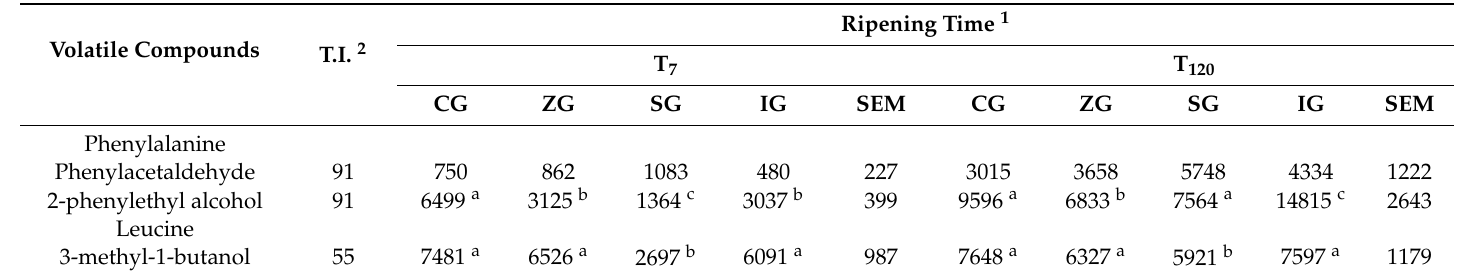
Data are reported as mean (%) ± S.D. of the total proteins found in the electrophoretic profile of each sample. α S -CN = α S -casein and β -CN = β -casein. Bands 1, 2, 3, 4, and 5 = fragments of protein degradation. * p < 0.05; ** p < 0.01; and ns = not significant. Table 4. Proteolytic volatile compounds in fresh (T 7 ) and 120-days ripened (T 120 ) cheese obtained from lactating cows fed control diet (CG) and control diet supplemented with zinc (ZG), selenium (SG), and iodine